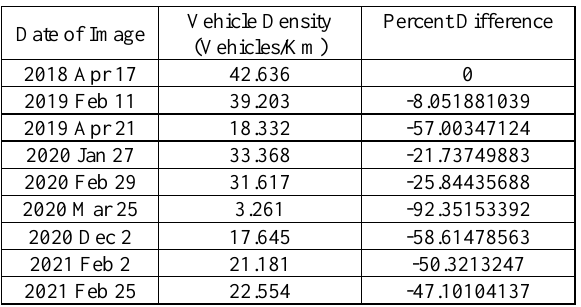
Table 6. Percent Differences of Vehicle Density from E. Rodriguez Ave.